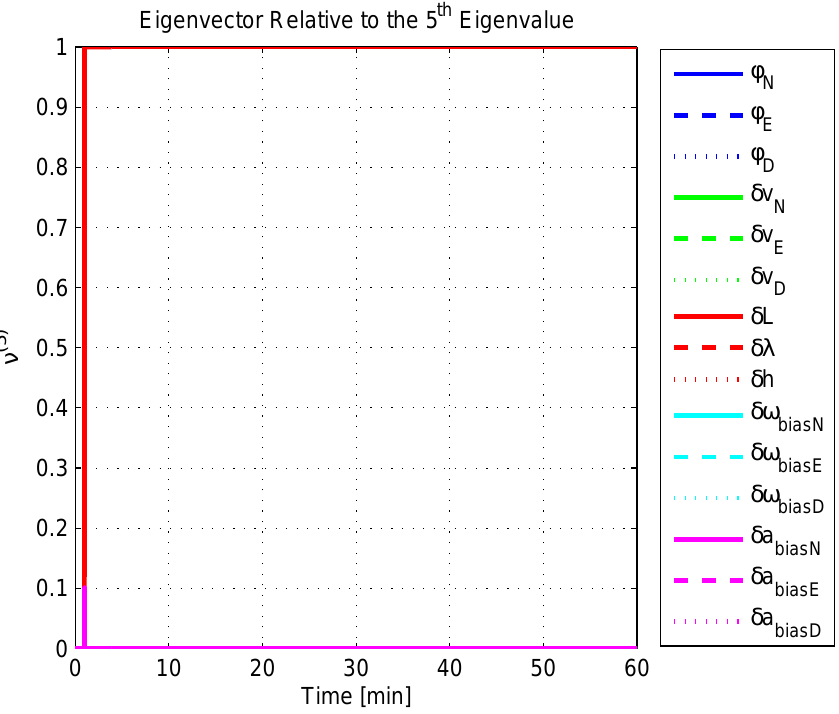
Figure 12. Eigenvector relative to the fifth eigenvalue in the simulated test.